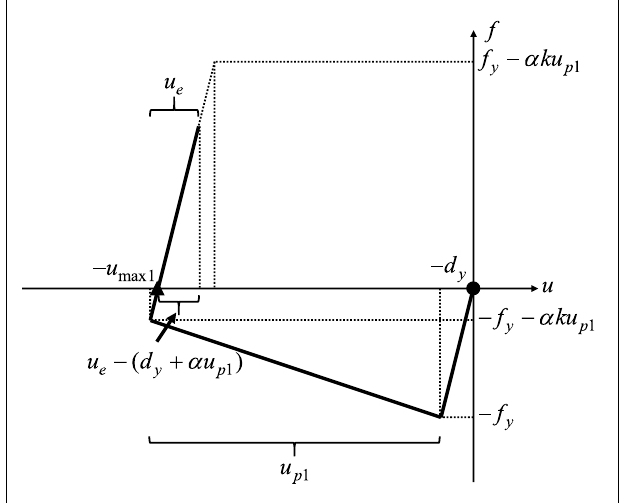
FIGURE 10 | Additional Pattern 2: limit without plastic deformation after the second impulse .